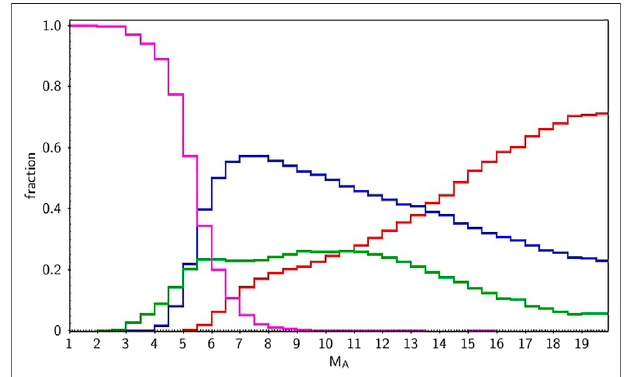
FIGURE4| Fractionsofthe differentsolar wind populations (SRR in red, SBO in blue, CHO in green and ejecta in magenta) as a function of M A .